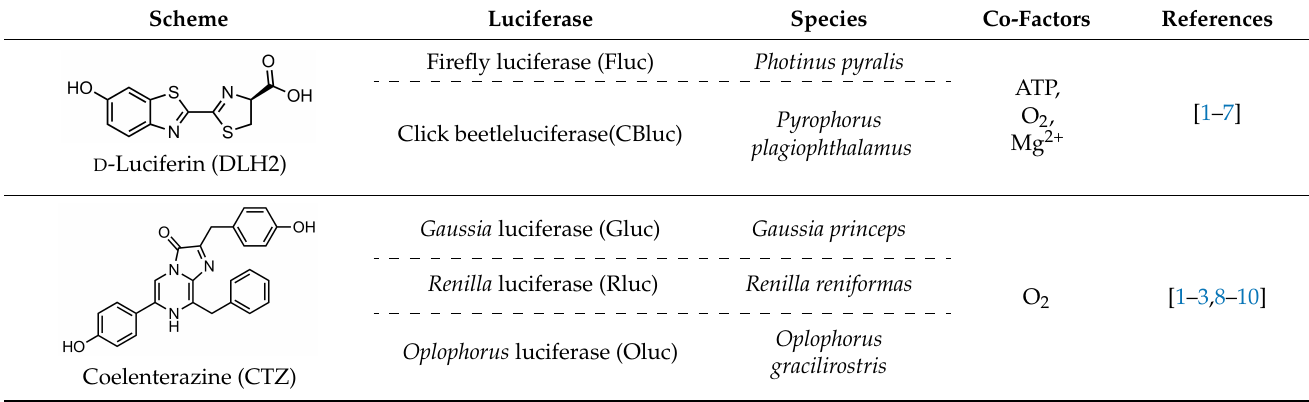
Table 1. Details of typical natural substrates and co-factors for bioluminescence reactions.